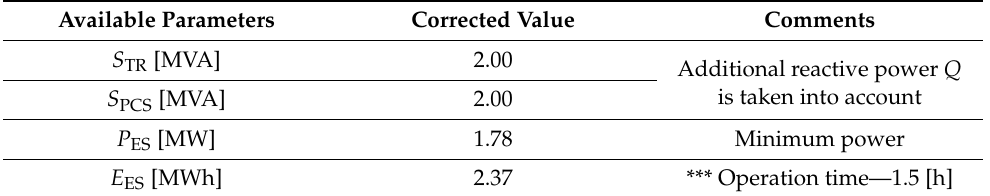
Table 7. Parameters of the